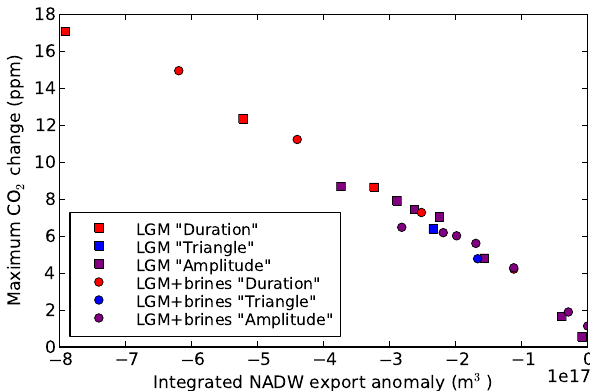
Fig. 15. Maximum of the CO 2 change (as a difference from the initial value) (ppm) as a function of the integrated NADW export anomaly over time (m 3 ). The NADW anomaly is taken as the dif- ference between the maximum value of the AMOC at a given time and the maximum value at the beginning of the